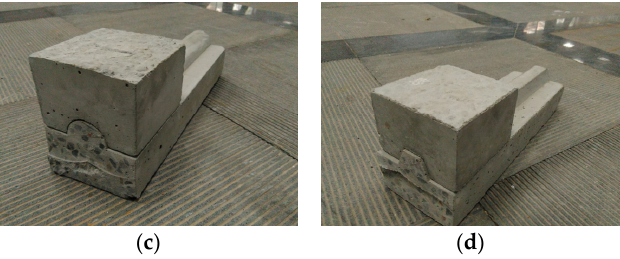
Figure 4. Photos for specimens of the bricks with various interlocking shapes: ( a ) non ‐ interlocking; ( b ) rectangular interlocking; ( c ) circular interlocking; ( d ) trapezoidal interlocking.